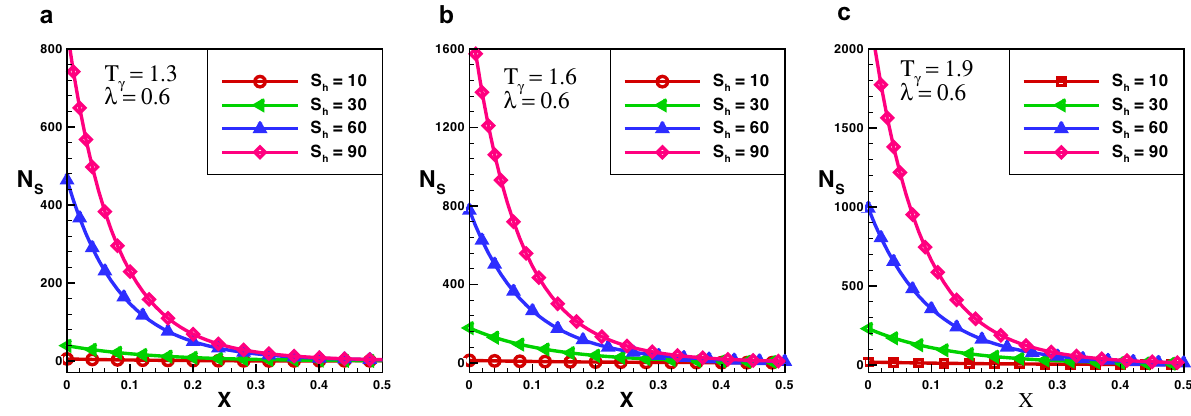
Figure 4. Entropy generation number in rectangular porous fin for (cid:31) = 0.6 .